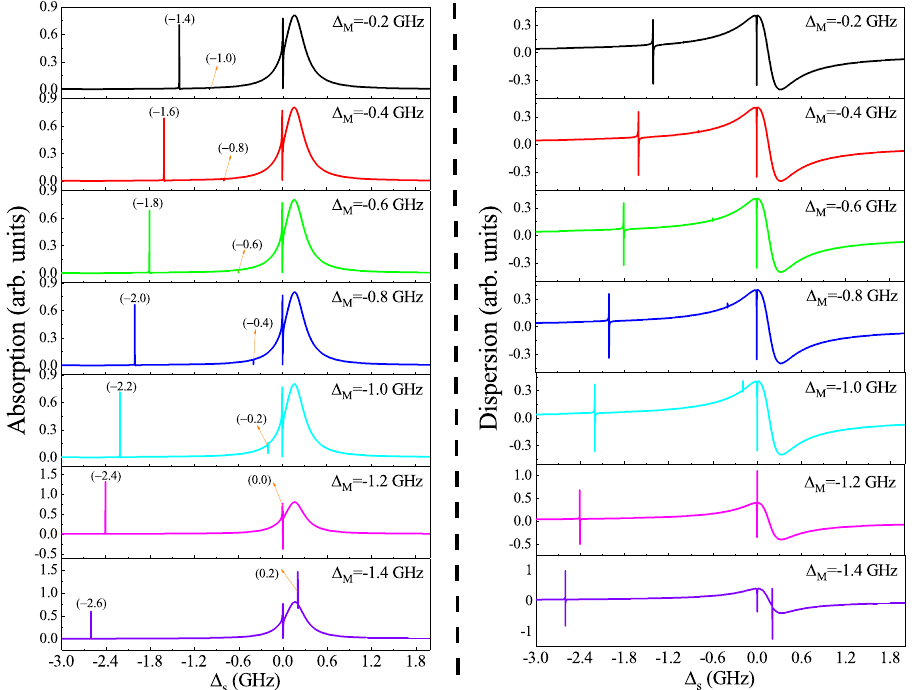
Figure 3. ( Left ) The absorption versus ∆ s for several different detuning ∆ M . ( Right ) The dispersion versus ∆ s for several different detuning ∆ M . The other parameters are g = 0.1 GHz, β = 0.06, ∆ Ω 2 = 0.1 (GHz) 2 . c = ω m , and c